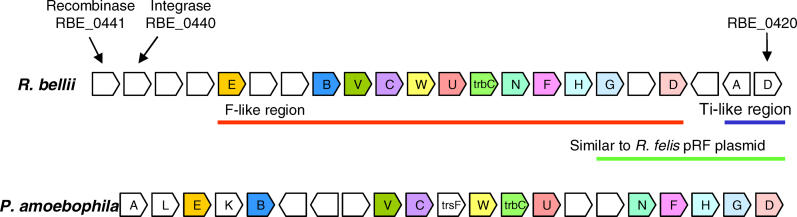
Alignment of the tra Gene Clusters Found in the Chromosomes of R. bellii and P. amoebophila
Homologous genes are indicated by the same color. For R. bellii, regions similar to tra genes in E. coli F plasmid, A. tumefacience Ti plasmid, and R. felis pRF plasmid are indicated by red, blue, and green bars, respectively.